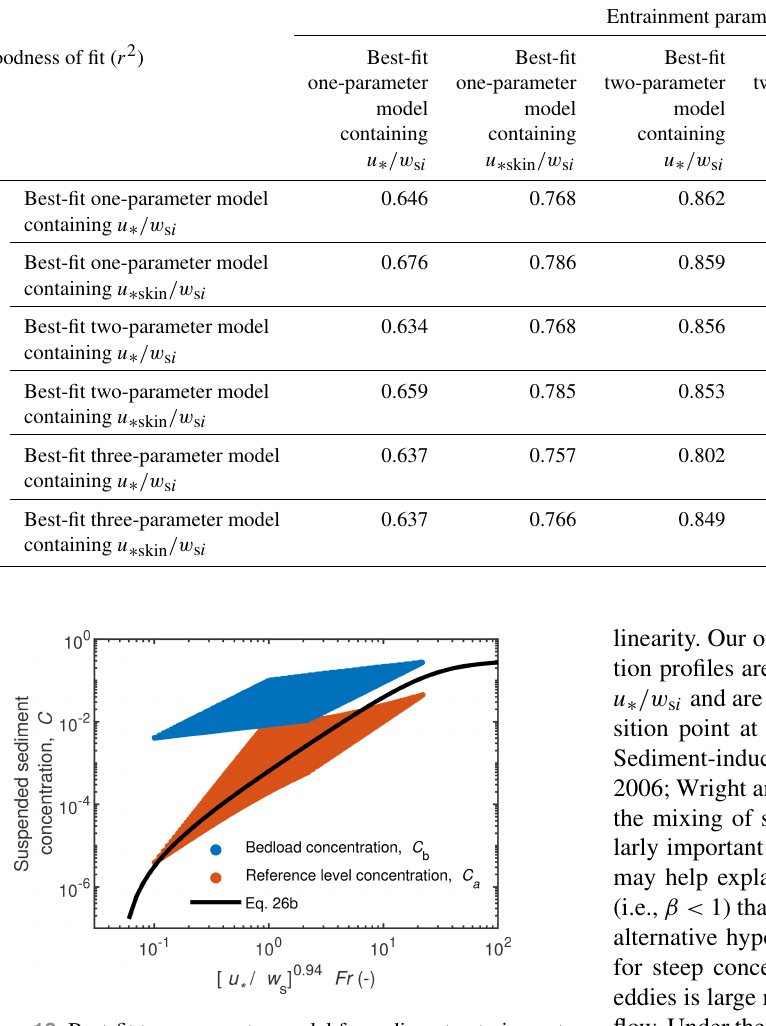
Figure 12. Best-fit two-parameter model for sediment entrainment without form drag, Eq. (26b), presented here for uniform gravel. The plotting is done such that the exponent on the last parameter is unity to allow for comparison to plots of Garcia and Parker (1991) and Wright and Parker (2004b). The colored regions are prediction envelopes for synthetic gravel data using the bedload-layer equa- tions to estimate the bedload volumetric concentration, C b , and the Rouse profile to interpolate higher in the water column to the refer- ence level at z = 0 . 1 H ( C a ). The synthetic data envelope represents a wide range of parameter space: 0 . 1 < Fr < 1 and 1 < τ ∗ <